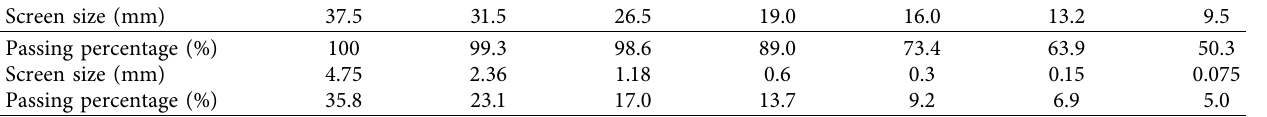
Table 2: AC-25 grading curve.